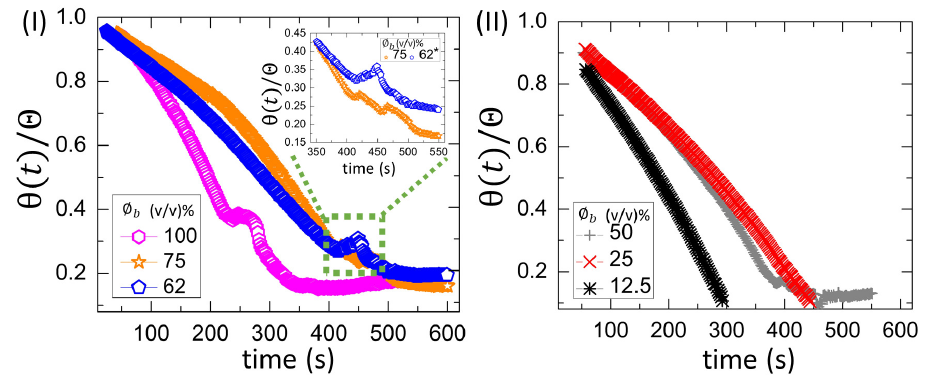
Figure 8. Time evolution of the normalized contact angle ( θ ( t ) / Θ ) in the whole blood droplets for T = 25 ◦ C at different initial concentrations ( φ b ) ranging from 100 to 62% ( v / v ) in ( I ) and from 50 to 12.5% ( v / v ) in ( II ). The range from 320 to 570 s is zoomed in the inset of ( I ) at φ b of 75 and 62% ( v / v ). The value of 0.05 is added to θ ( t ) / Θ of 62% ( v / v ) (illustrated with an asterisk mark) for the clear visualization.